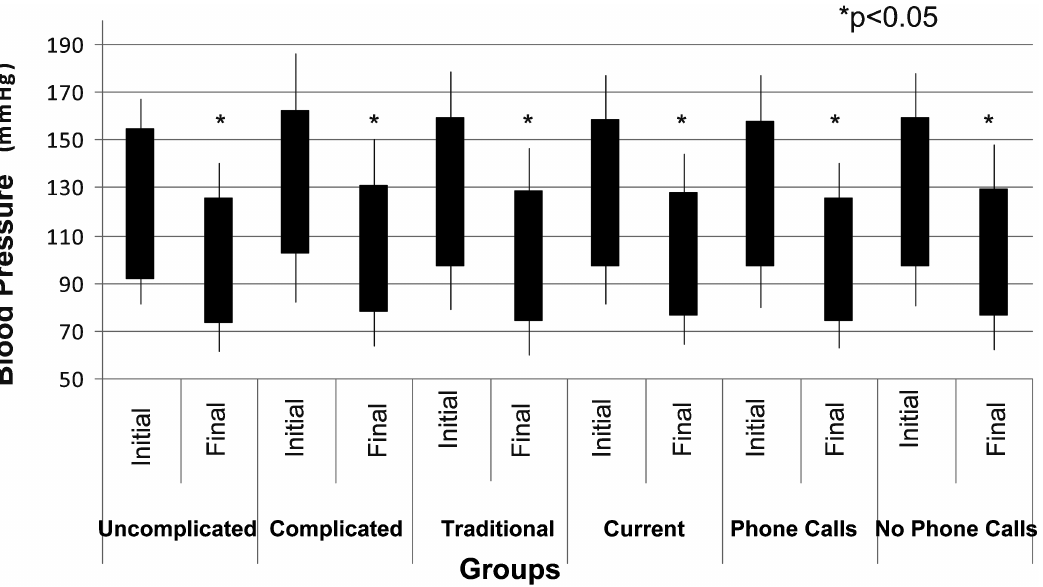
Figure 1 - IASH 2009 How to avoid discontinuation of antihypertensive treatment: the experience in Sa˜o Paulo, Brazil.